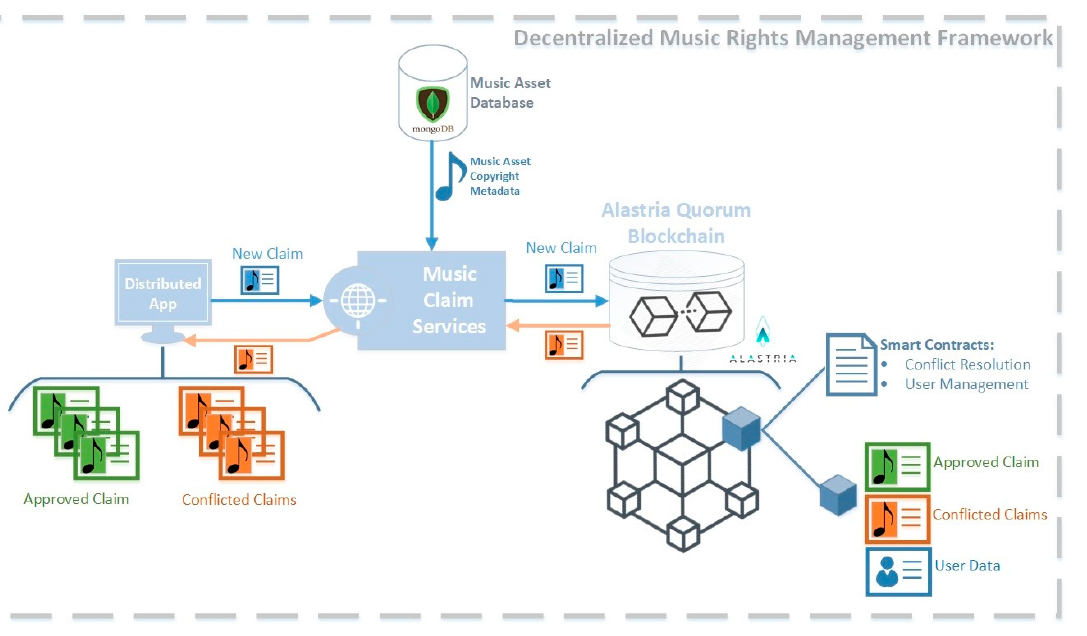
Figure 2. Decentralized music rights management framework.